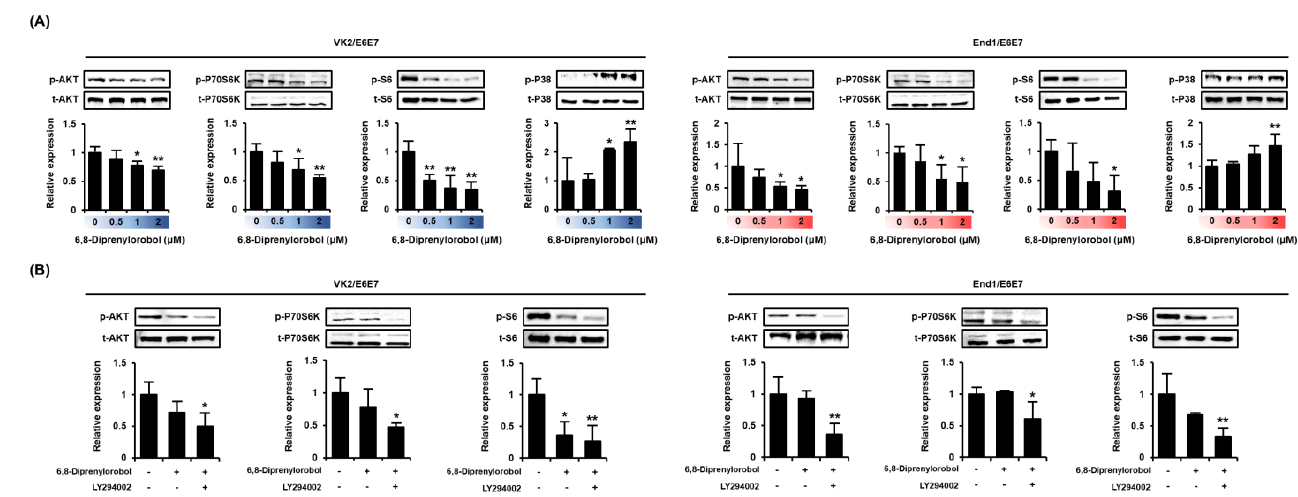
Figure 6. Regulation of PI3K/AKT signaling pathways by 6,8-diprenylorobol in human endometriosis cells. ( A ) Phosphorylation of AKT, P70S6K, S6, and P38 in response to dose-dependent treatment of 6,8-diprenylorobol. ( B ) Phosphorylation of AKT, P70S6K, and S6 in response to LY294002 treatment with 6,8-diprenylorobol. Immunoblots were captured and digitized using a ChemiDoc EQ system and Quantity One software. Each value was normalized by each total form of proteins and represented as fold changes in the graph. Asterisks indicate significant levels between vehicle-treated cells and 6,8-diprenylorobol-treated cells (* p < 0.05 and ** p < 0.01).